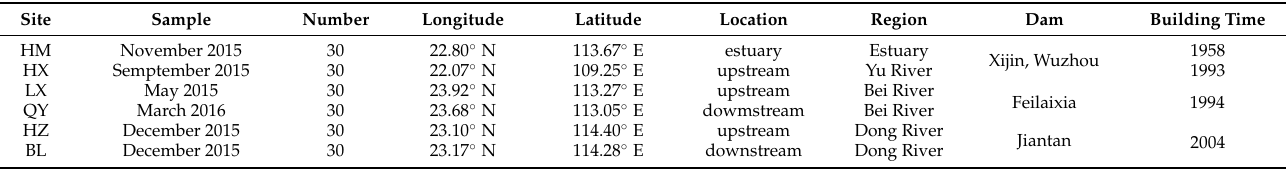
Table 1. Detailed information on the sample sites in this